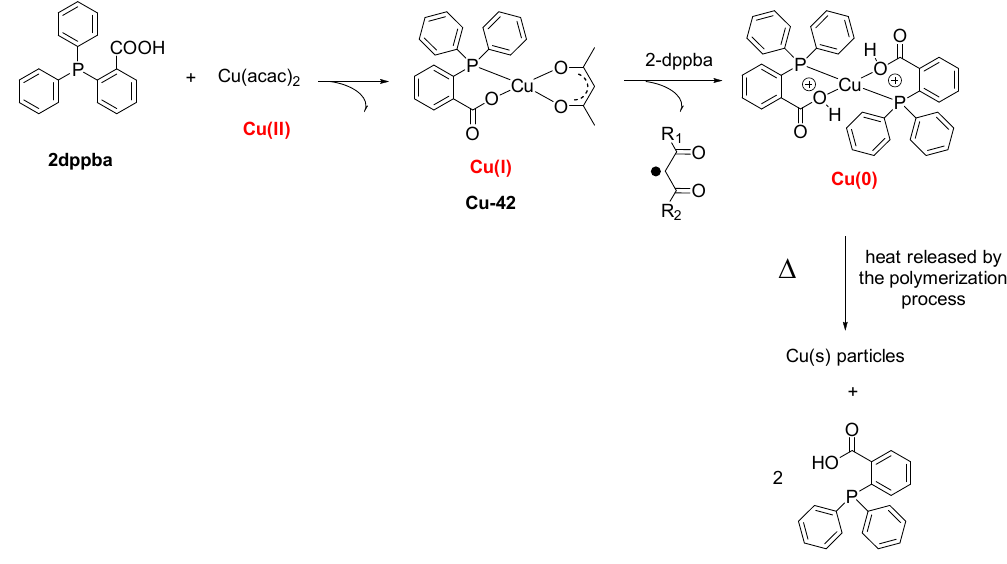
Scheme 3. Successive ligand exchange involved in the MABLI process.